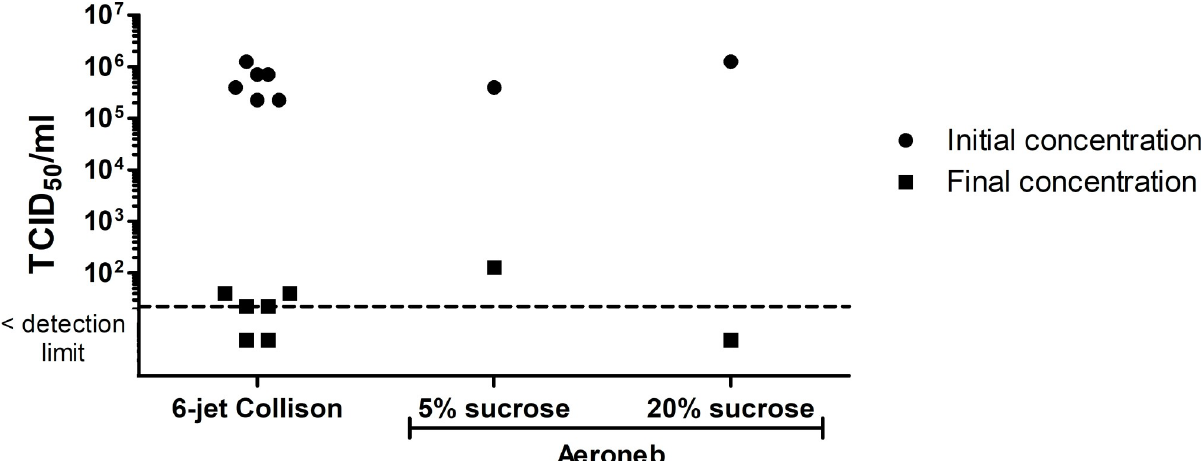
Fig 4. Initial and final infectious RSV concentrations in the 6-jet Collison and the Aeroneb nebulizers. The detection limit (2.24 X 10 1 TCID 50 /ml) is represented by the dotted line and corresponds to one positive well.